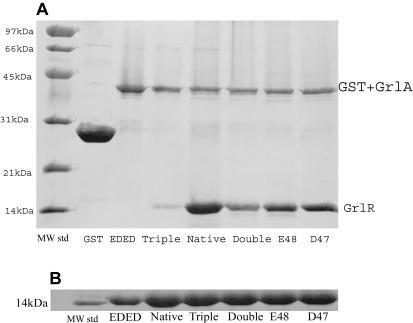
In Vitro Pull-Down Assay(A) SDS-PAGE gel showing the in vitro pull-down assay to demonstrate the binding of wild-type GrlR and EDED mutants to GrlA. Lane 1, molecular weight marker (MW); lane 2, GST; lane 3, E46A-D47A-E48A-D49A; lane 4, E46A-D47A-E48A; lane 5, wild-type GrlR; lane 6, E46A-D47A; lane 7, E48A; lane 8, D47A. The bands corresponding to GST-GrlA and GrlR were further identified by peptide mass finger printing. The staining was done using coomassie brilliant blue.(B) SDS-PAGE gel showing the amount of native and mutant GrlR protein used for the in vitro pull-down assay. Lane 1, molecular weight marker; lane 2, E46A-D47A-E48A-D49A; lane 3, wild-type GrlR; lane 4, E46A-D47A-E48A; lane 5, E46A-D47A; lane 6, E48A; lane 7, D47A.